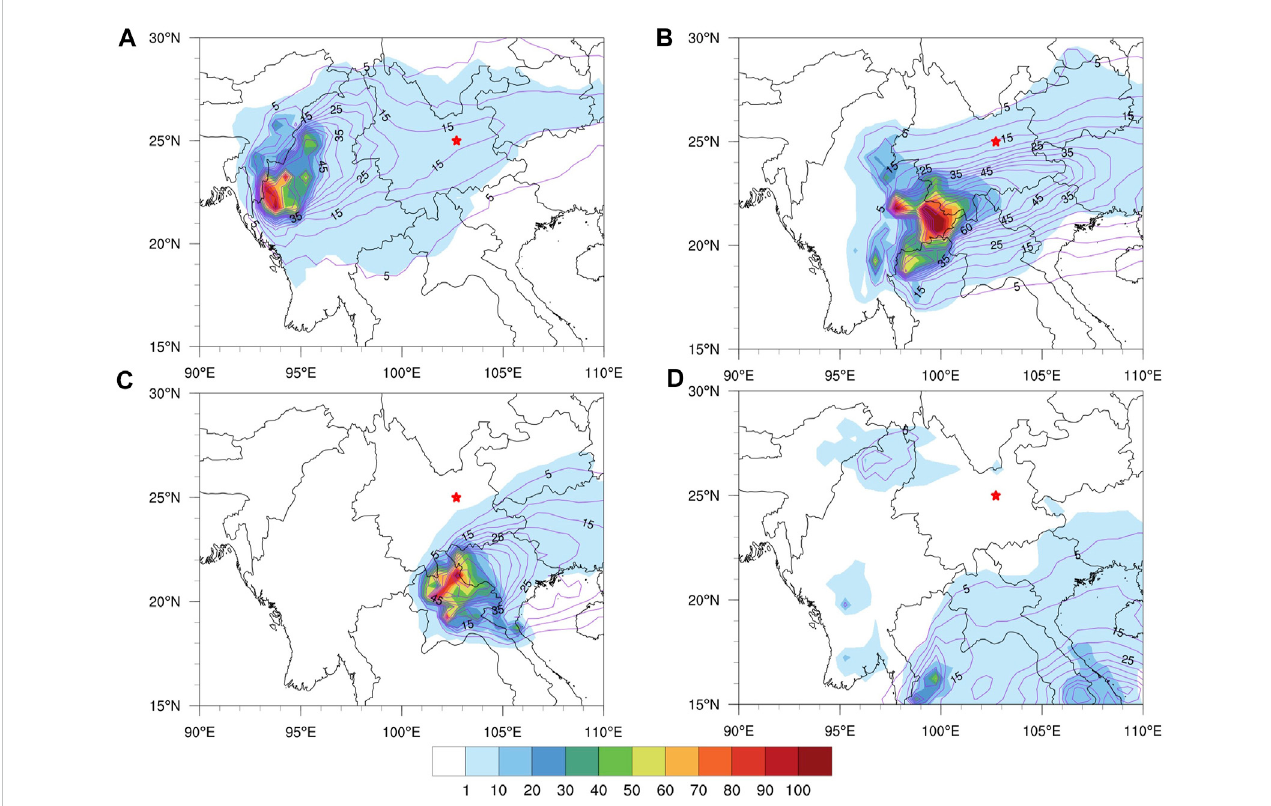
FIGURE 11 The model simulated mean near surface PM 2.5 concentrations ( μ g m − 3 )(Fill color) and PM 2.5 columnconcentrations (mg m − 2 )in thetroposphere (Purple contour) produced by biomass burning in different regions of Southeast Asia during 28 March to 2 April 2019 (A) : Region 1; (B) : Region 2; (C) : Region 3; (D) : Other regions). The red stars denote the location of Kunming